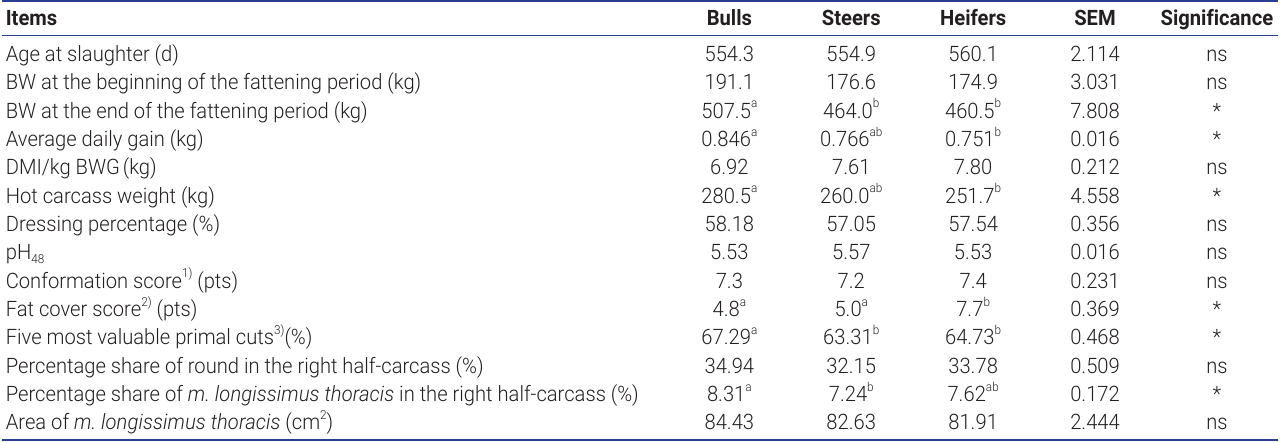
Table 2. Fattening performance and carcass characteristics of fattened bulls, steers and heifers